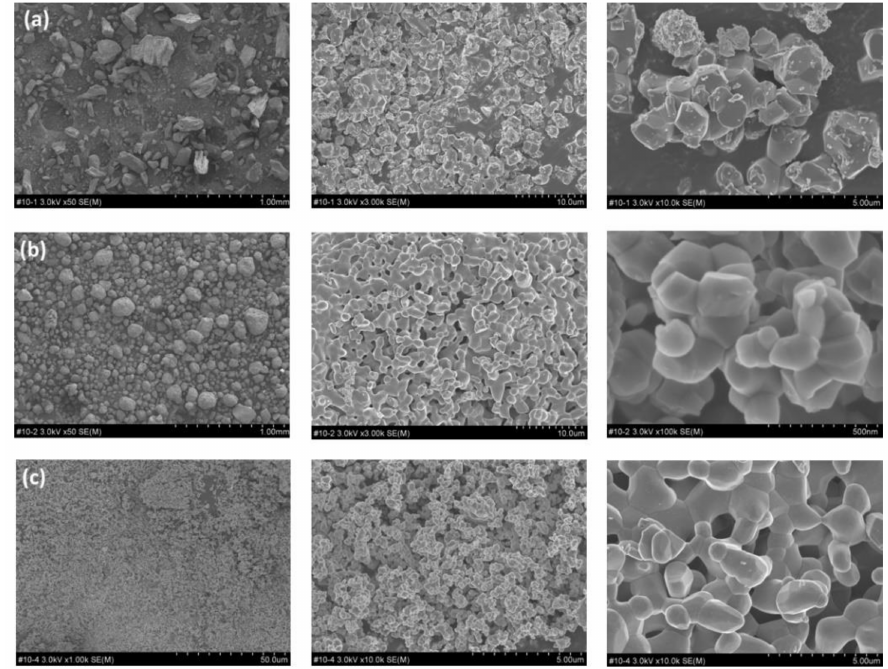
Figure 5. SEM images providing a comparative analysis of oyster shell particle morphology and spacing in response to plastic working: ( a ) untreated oyster shell particles, ( b ) particles after plastic working at 600 ◦ C, and ( c ) particles after plastic working at 1200 ◦ C.